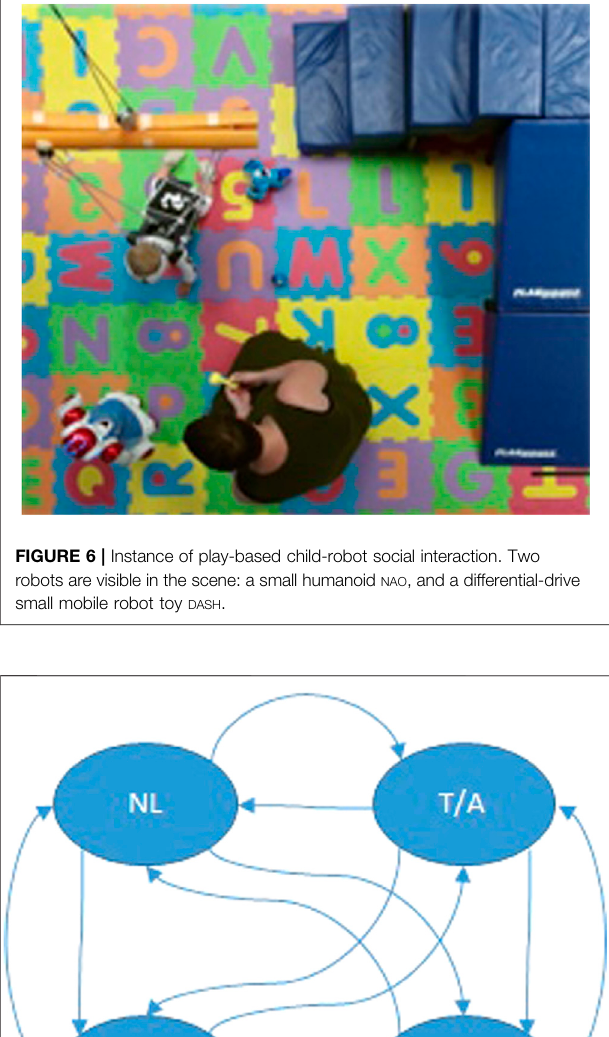
Frontiers in Robotics and AI |